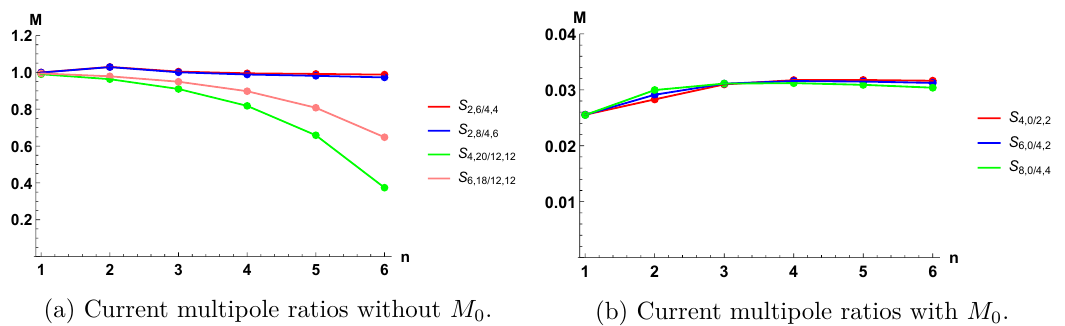
Figure 5. Current multipole ratios computed from symmetric pincers ( n, n ) with n = 1 , · · · , 6 (section